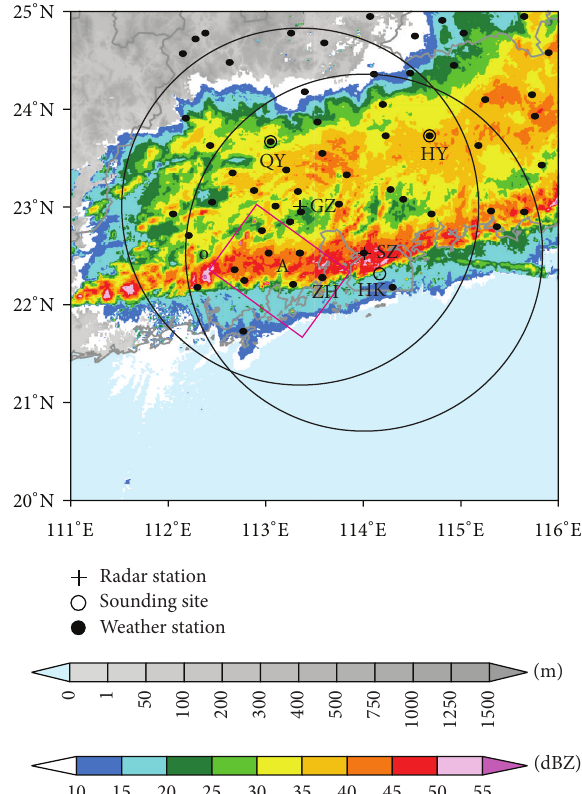
Figure 1: Map of the dual-Doppler radar observation network and the mesonet weather stations. The colour shading shows the composite reflectivity (dBZ) on 1017LST 24 April 2007 and the gray shading for the altitude (m). The two large circles represent Guangzhou (GZ) and Shenzhen (SZ) radars scan domains, respec- tively. Rectangle A shows the dual-Doppler wind retrieval domain, and “o” indicates the origin of the wind retrieval coordinate system. ZH represents Zhuhai weather